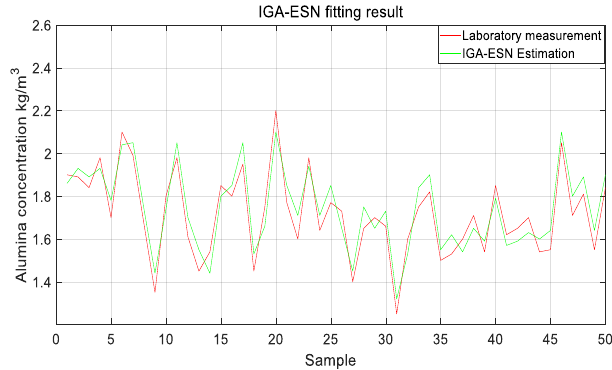
Figure 14. Fitting results of alumina concentration by IGA-ESN.